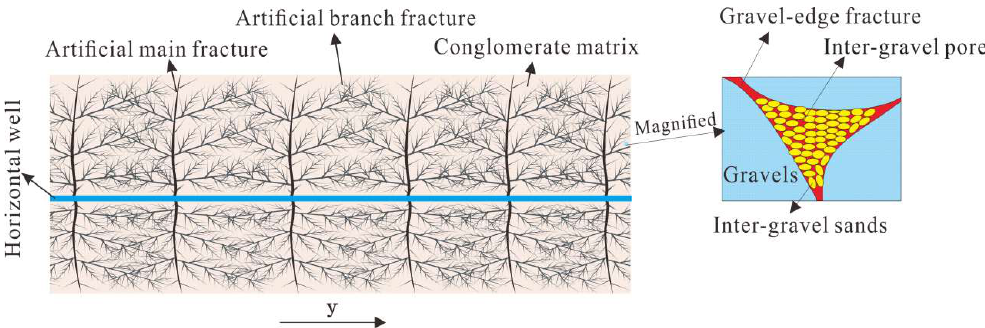
Figure 5. Schematic diagram of the complex fracture network in tight conglomerate reservoirs.